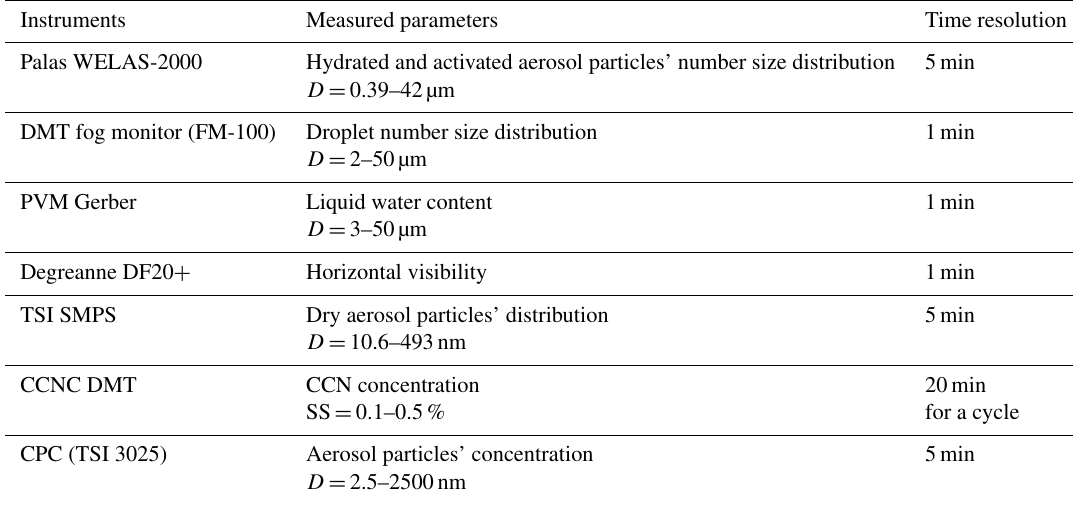
Table 1. Instruments deployed during the campaigns that are used for this study.